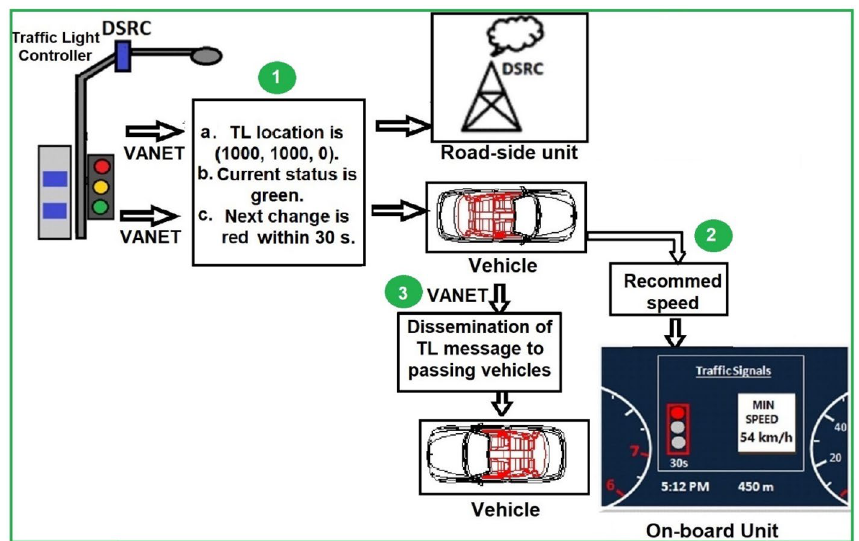
Figure 1. A framework for traffic light recognition using